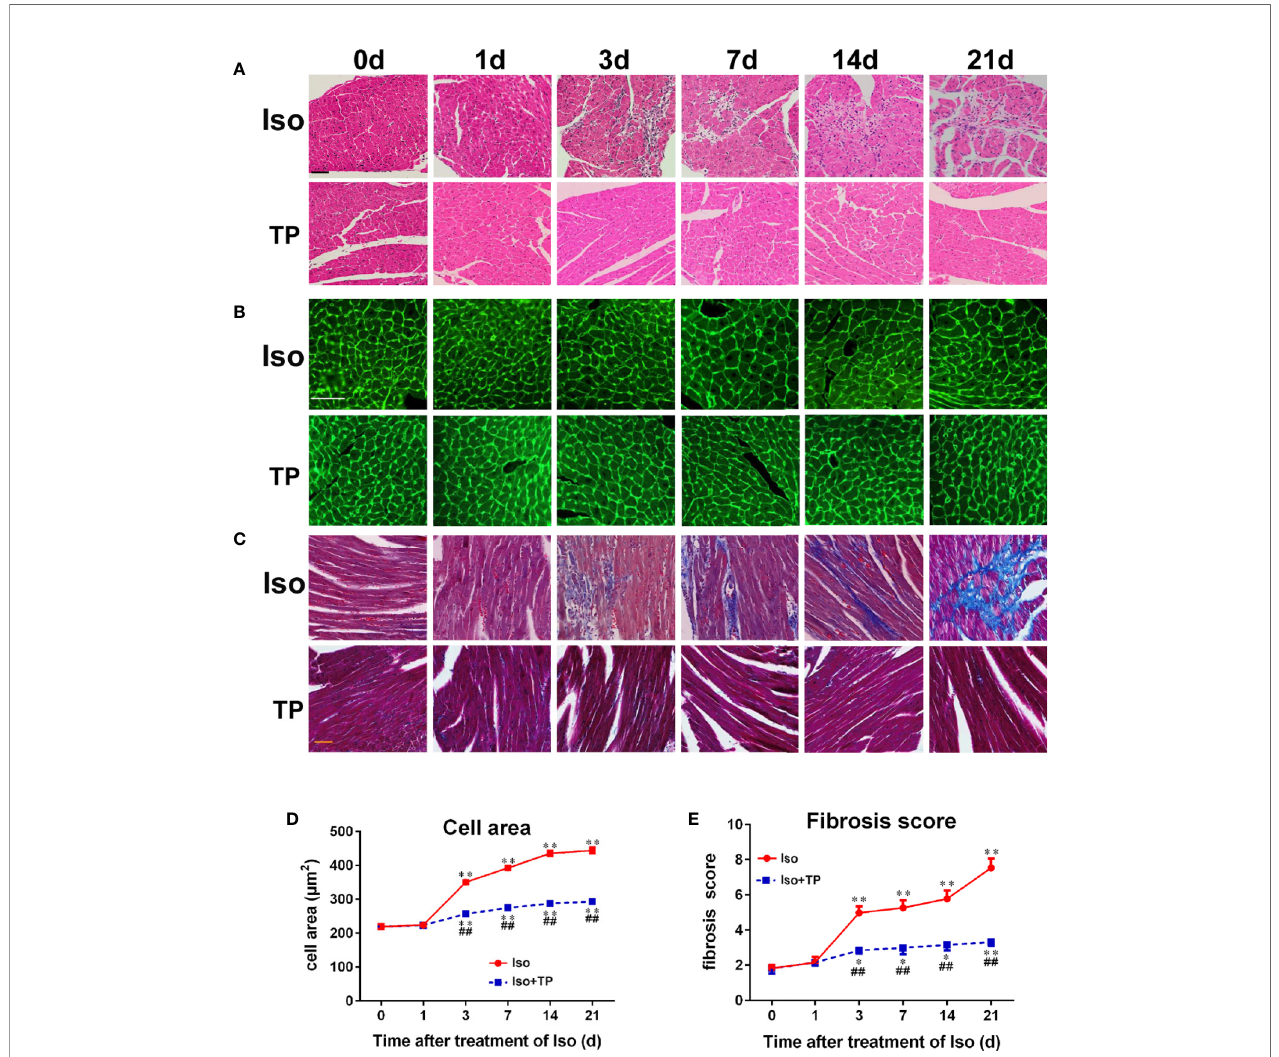
FIGURE 5 | Myocardial histological changes after TP treatment. (A) Hematoxylin and eosin (HE) staining of myocardial LV tissue (bar = 50 µm). (B) Wheat germ agglutinin lectin staining (bar = 50 µm). (C) Masson ’ s trichome-stained left ventricular tissue (bar = 50 µm). (D) Cross-sectional area ( n = 80). (E) Fibrosis score. Data are shown as the mean ± SEM ( n = 6 in each group), *P < 0.05, **P < 0.01 compared with the controls (0 day); ## P < 0.01 compared with the Iso-treated group at the same time point (one-way